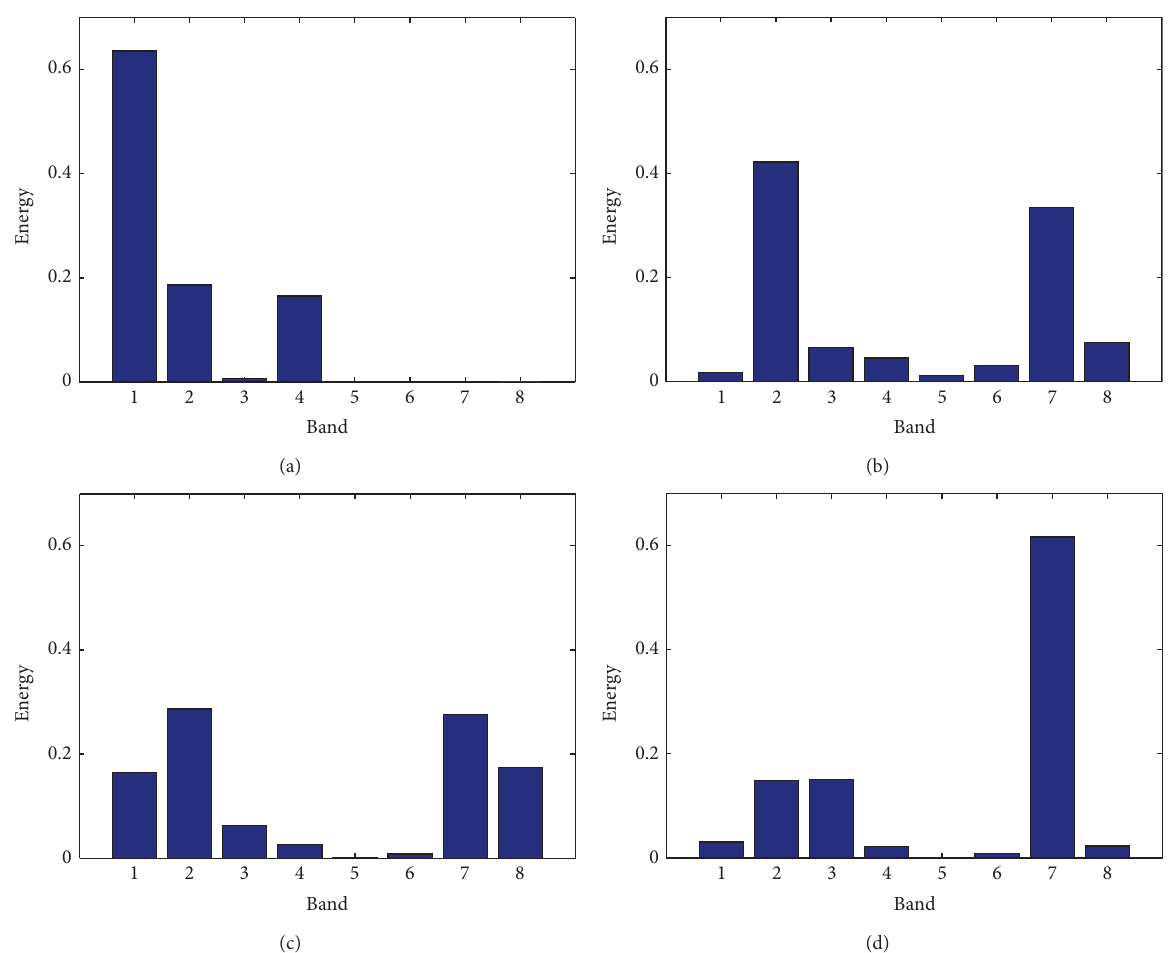
Figure 5: Wavelet packet energy spectrums of bearing vibration signals under four conditions: (a) normal, (b) inner race fault, (c) ball fault, and (d) outer race